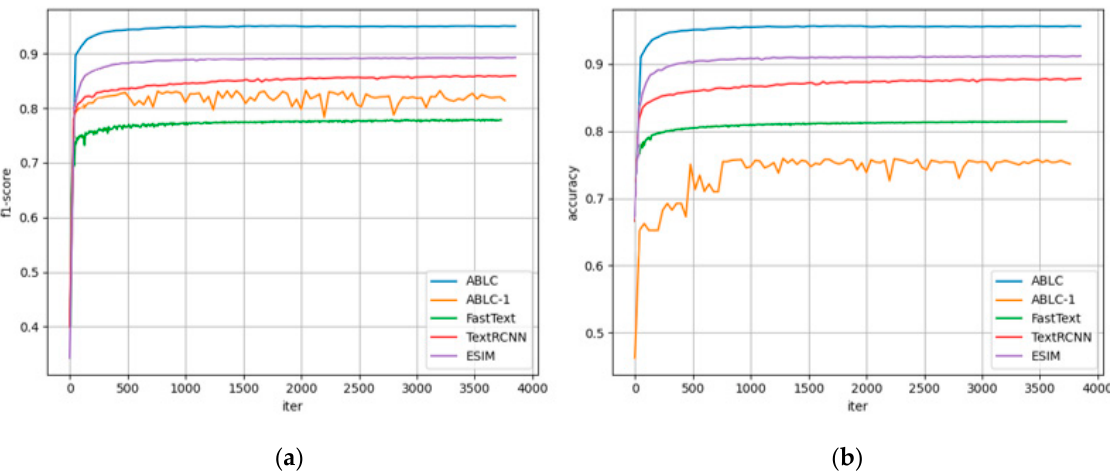
Figure 8. ( a ) F1 score of different models compare with ABLC. ( b ) Accuracy of different models compare with ABLC.